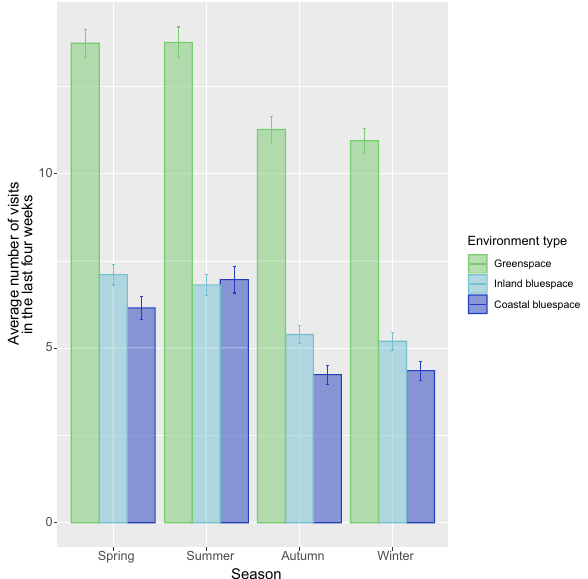
Figure 2. Average number of visits to green spaces, inland-blue spaces and coastal-blue spaces as a function of season across the whole sample (n = 16,302). Error bars represent 95% confidence